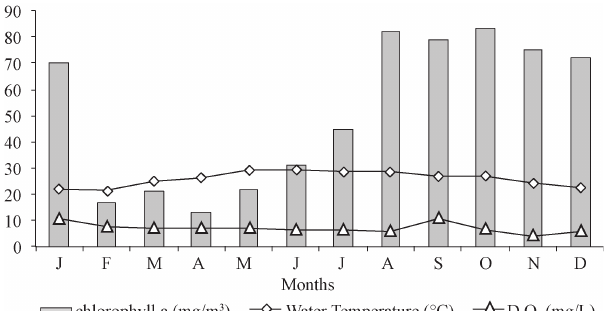
Fig. 8. Seasonal variation of chlorophyll a concentration (mg/m³), water temperature (°C) and dissolved oxygen (mg/L) at Emiliano Zapata